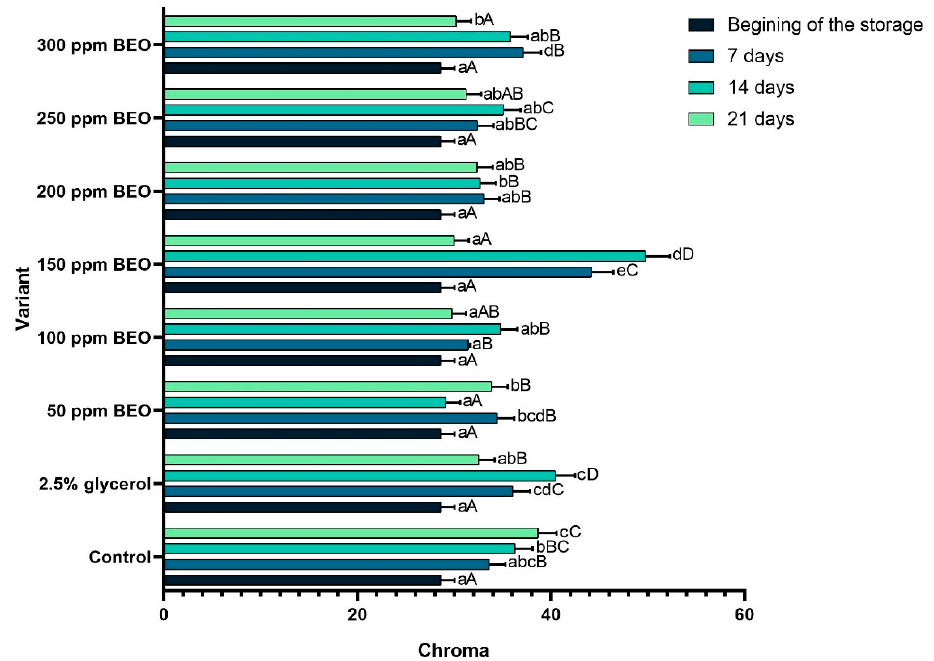
Figure 9. Effects of applied treatments on the Chroma (fruit color parameter) during storage for 21 days at 8 ± 1 ◦ C. Bars for the same sampling time followed by different lowercase letters are significantly different based on the least significant difference (LSD) test ( p < 0.05). Bars for the same treatment during storage time followed by different uppercase letters are significantly different based on the least significant difference (LSD) test ( p < 0.05).